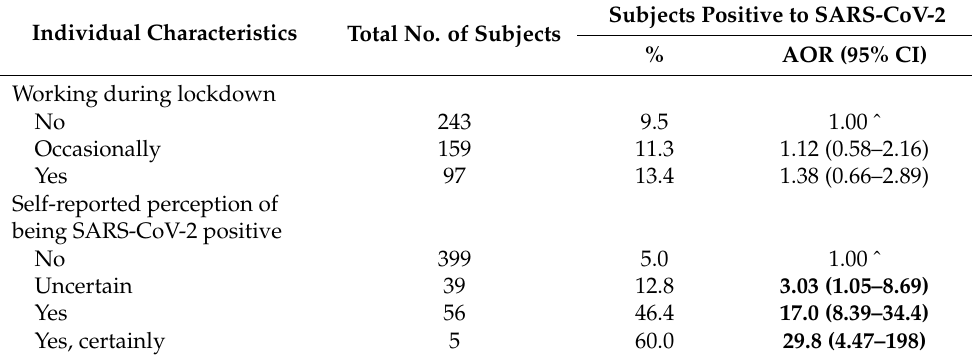
Table 4. Distribution of 499 workers in dentistry with valid test, by SARS-CoV-2 positivity, overall and according to selected COVID-related characteristics. Corresponding adjusted odds ratios * (AOR) and 95% confidence intervals (CI). Lombardy region (Italy),